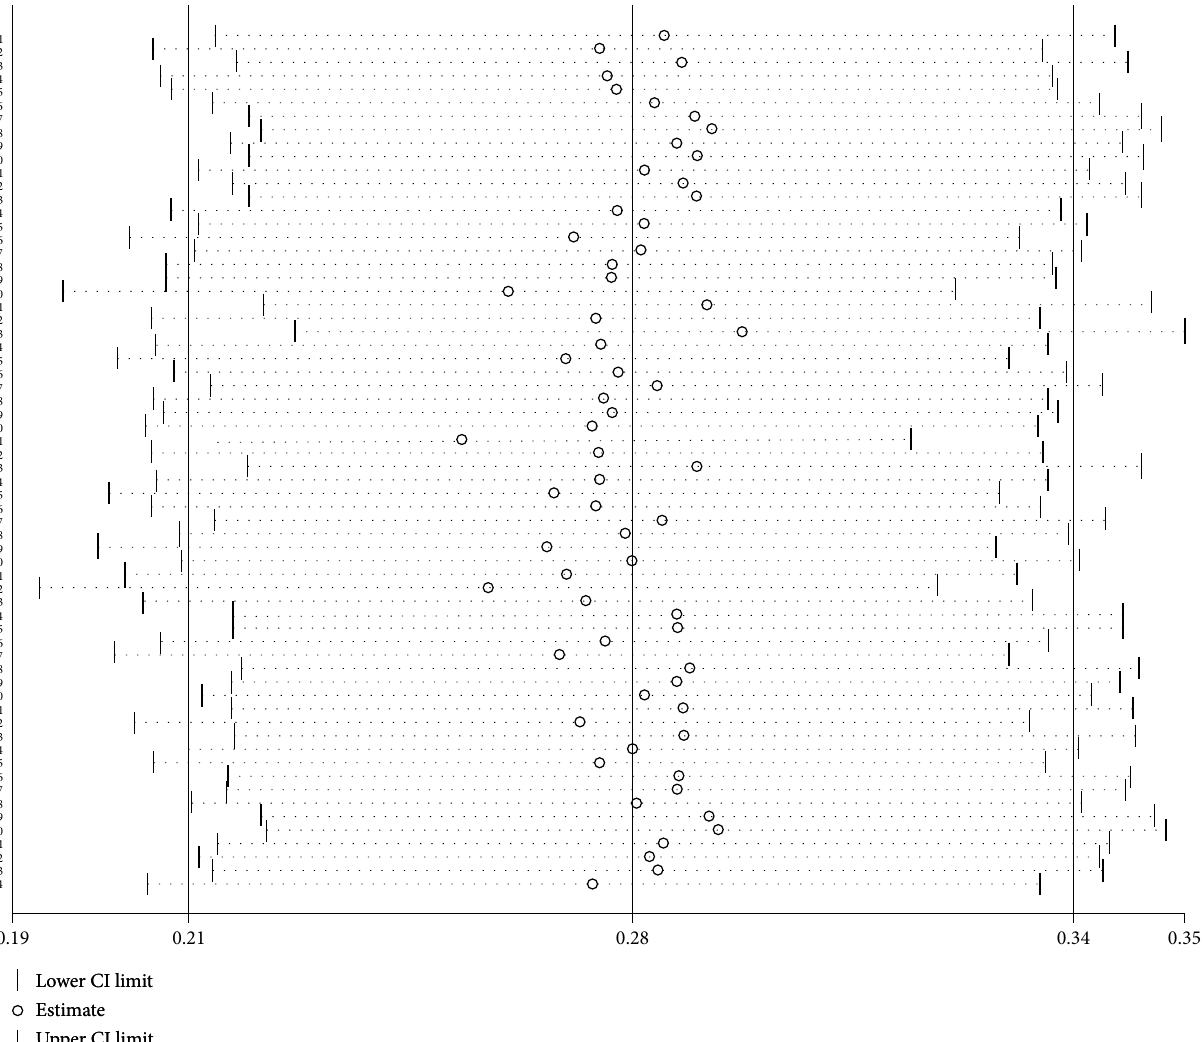
F IGURE 5: Results of the in fl uence analysis.